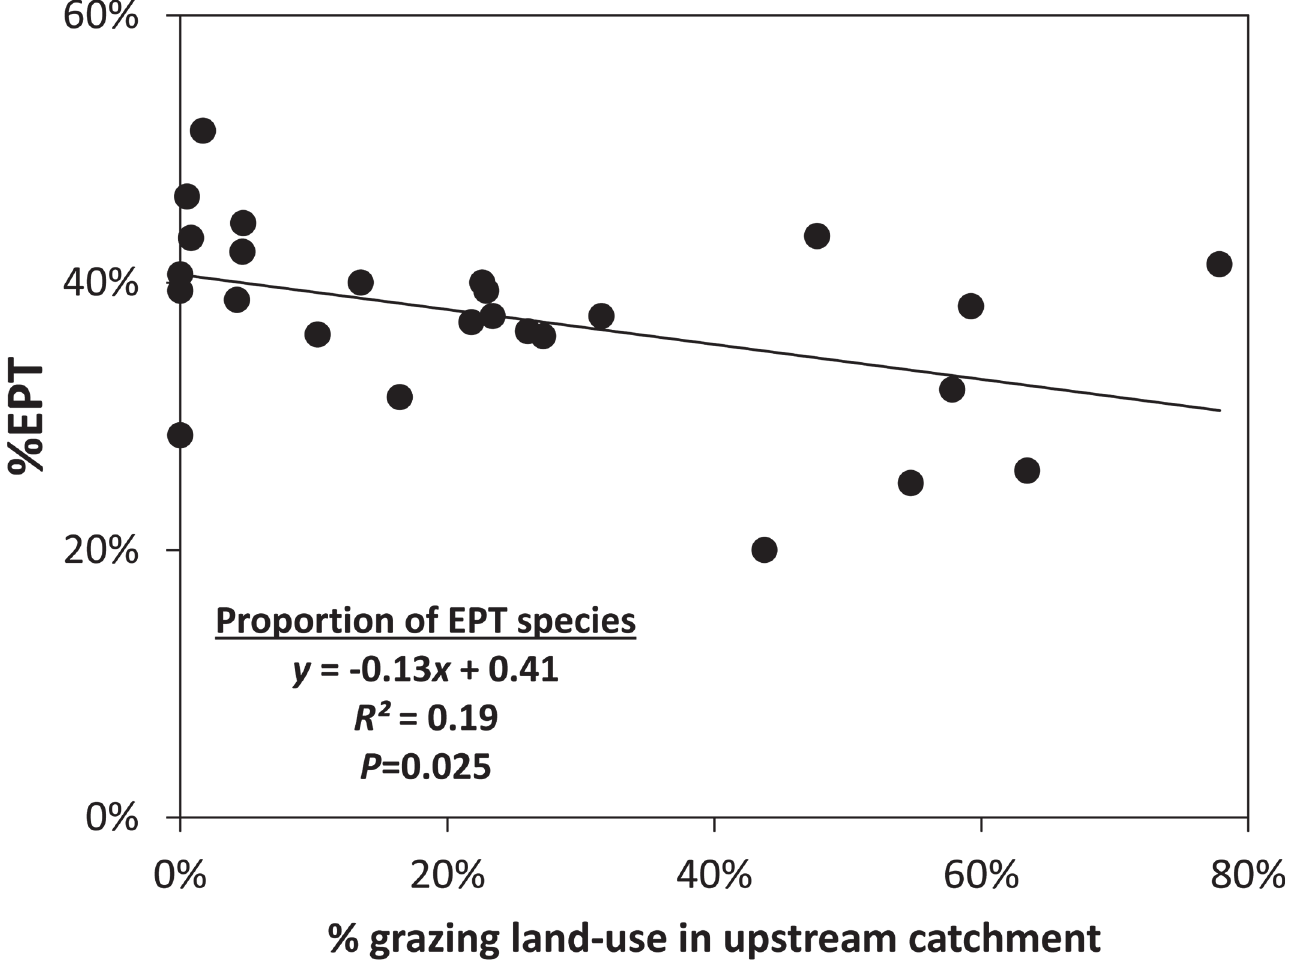
Fig 4. Relationship between %EPT and proportion of upstream catchment subject to